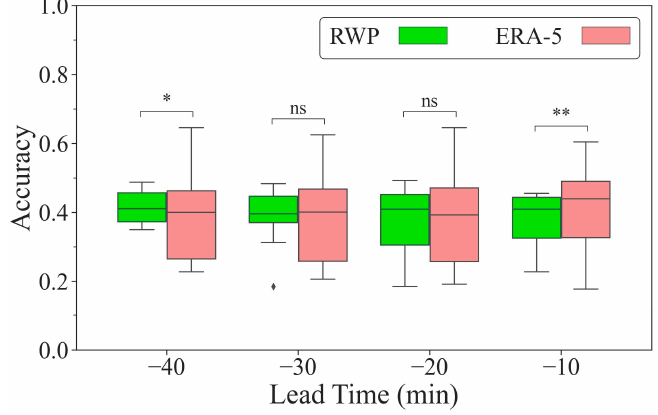
Figure 11. Box plots showing the accuracy used to assess the RF model for the rainfall grade forecast, which is based on RWP measurements (in green) and ERA-5 reanalysis data (in pink), respectively. * and ** above the box plot represents statistical significance passing the 95% and 99% confidence level, whereas “ns” represents no statistical significance, and outliers are indicated by black dots.